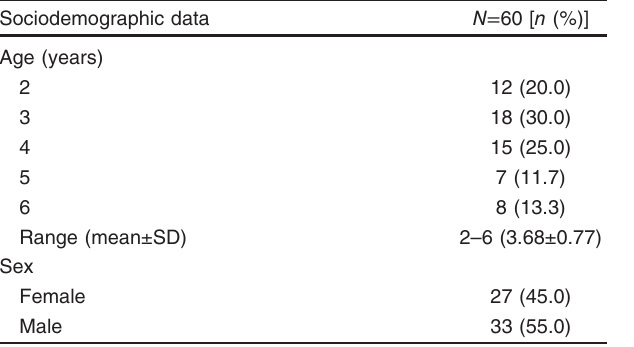
Table 1 Sociodemographic data distribution of the study groups Sociodemographic